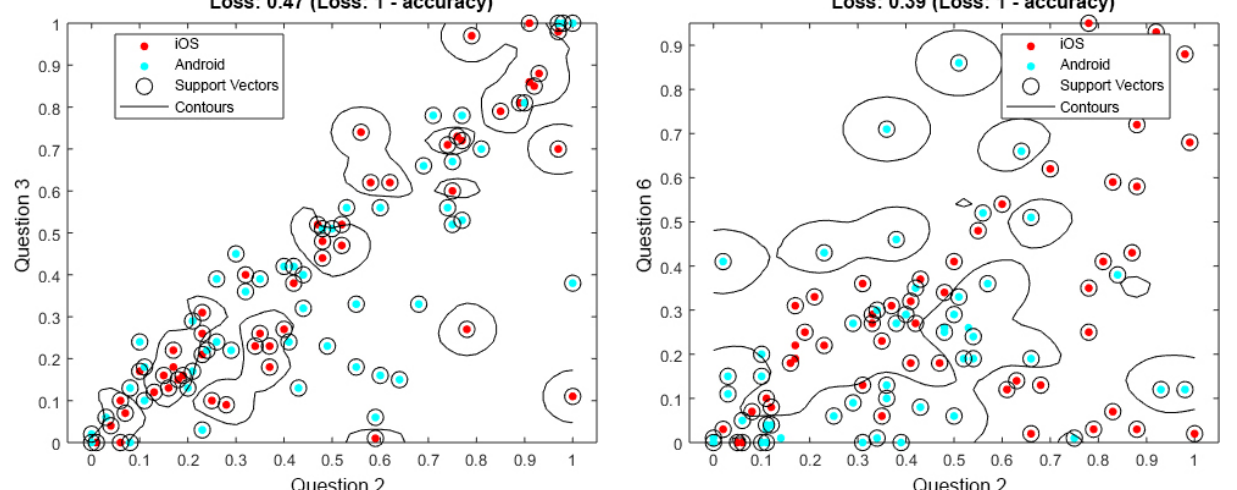
Figure 6. Support vector machine (SVM) results for question 2 (Q2), combined with question 3 (Q3) and question 6 (Q6), from 100 data entries. Q2: How loud is the tinnitus right now? (slider); Q3: How stressful is the tinnitus right now? (slider); and Q6: Do you feel stressed right now? (slider).